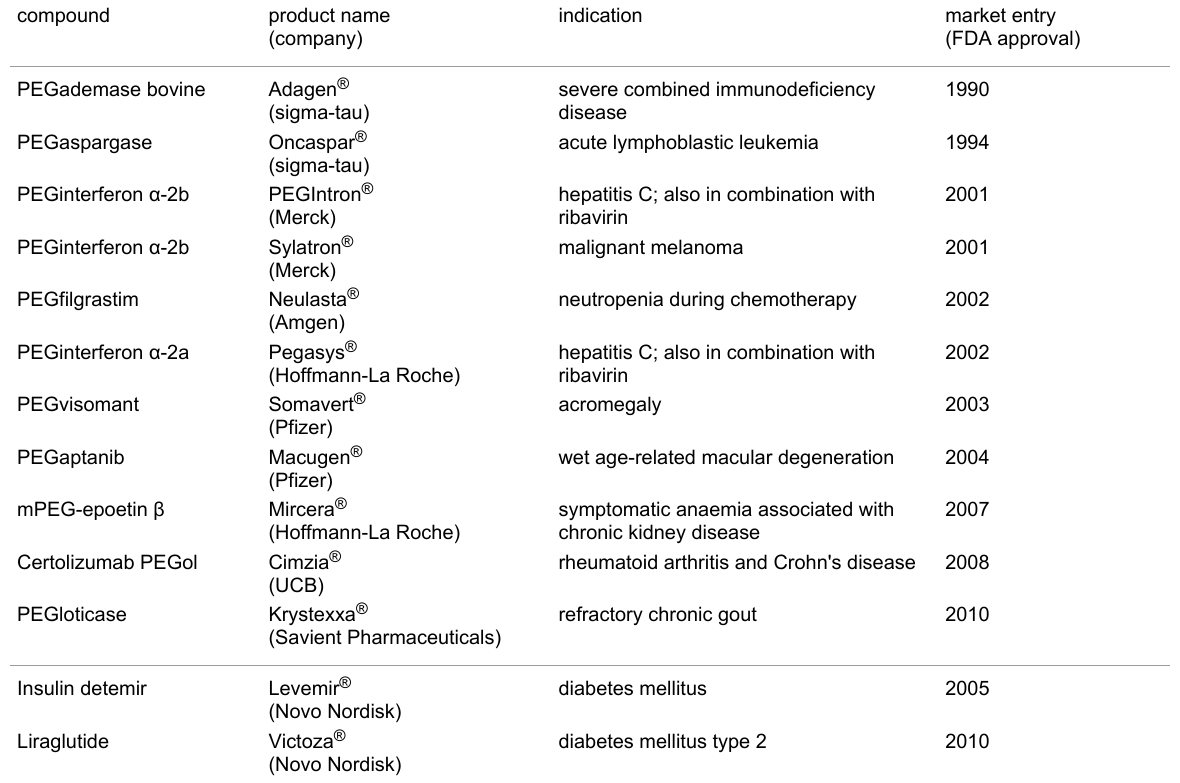
Table 2: PEGylated and lipidated peptide and protein drugs on the market, as stated by the FDA [11].